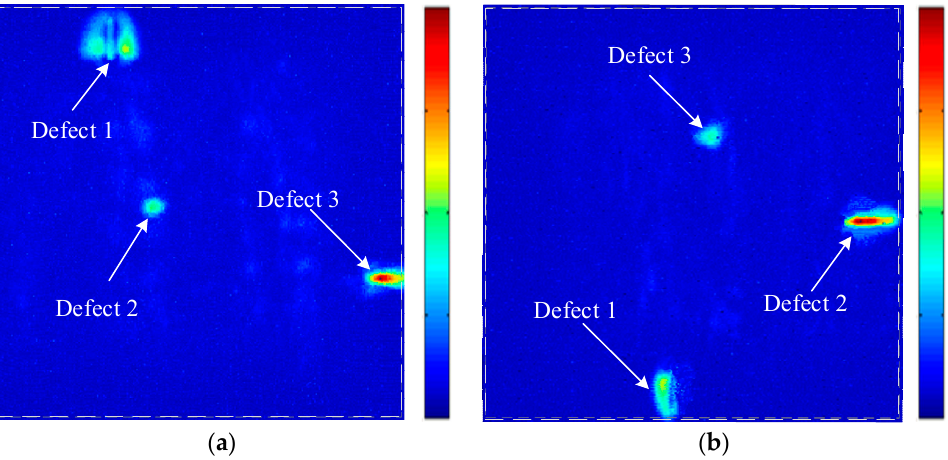
Figure 9. The TFM inspection results of the annular array when the beam is vertical to the deposition direction. ( a ) The C-scan image of deposition surface-1. ( b ) The C-scan image of deposition surface-2.